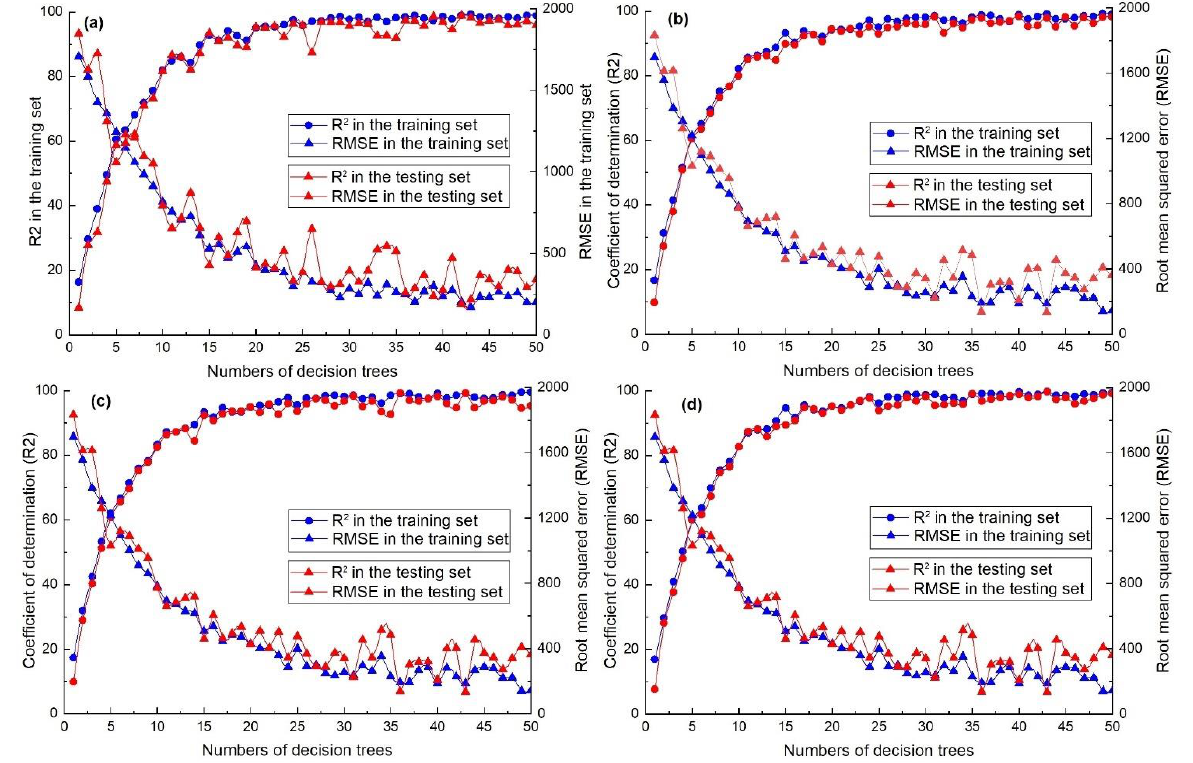
Figure 9. The performance of lightGBM according to the numbers of decision trees: ( a ) based on the original data set, ( b ) based on the PCA data set, ( c ) based on the ISOMAP data set, and ( d ) based on the UMAP data